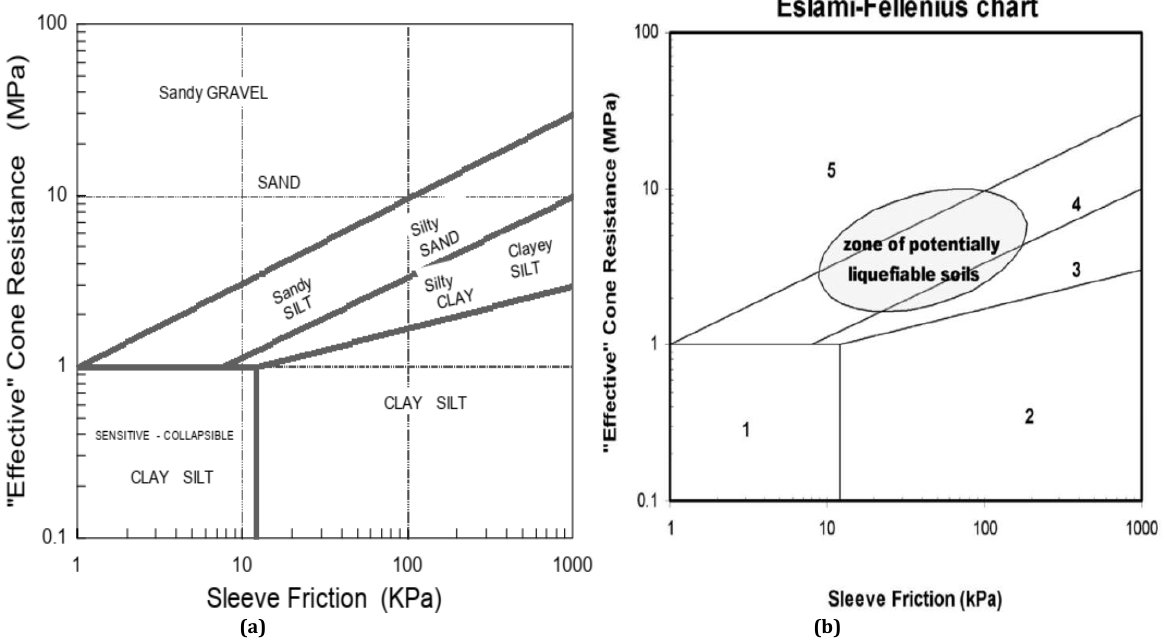
Figure 5: a) Eslami and Fellenius [19] characterizing chart as cone sleeve friction and effective cone resistance, b) Ahmadi et al. CPTu zone detecting curve for liquefaction potential